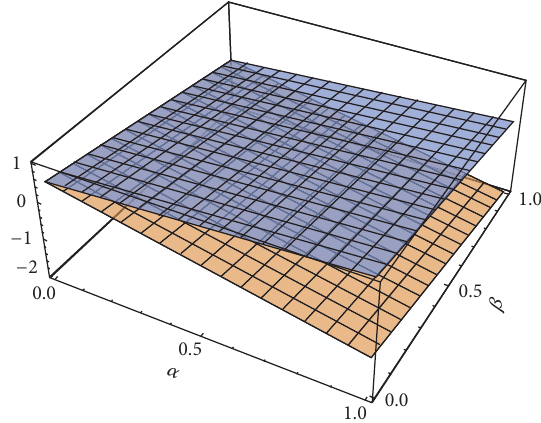
Figure 1: In this figure we plot the planes 𝜋 − (𝛼,𝛽) (orange, bottom) and 𝜋 + (𝛼,𝛽) (blue, top) for 𝑁 = 0 and 𝑠 = +1 . The region between the two planes is that in which the operator ℎ 0 is not